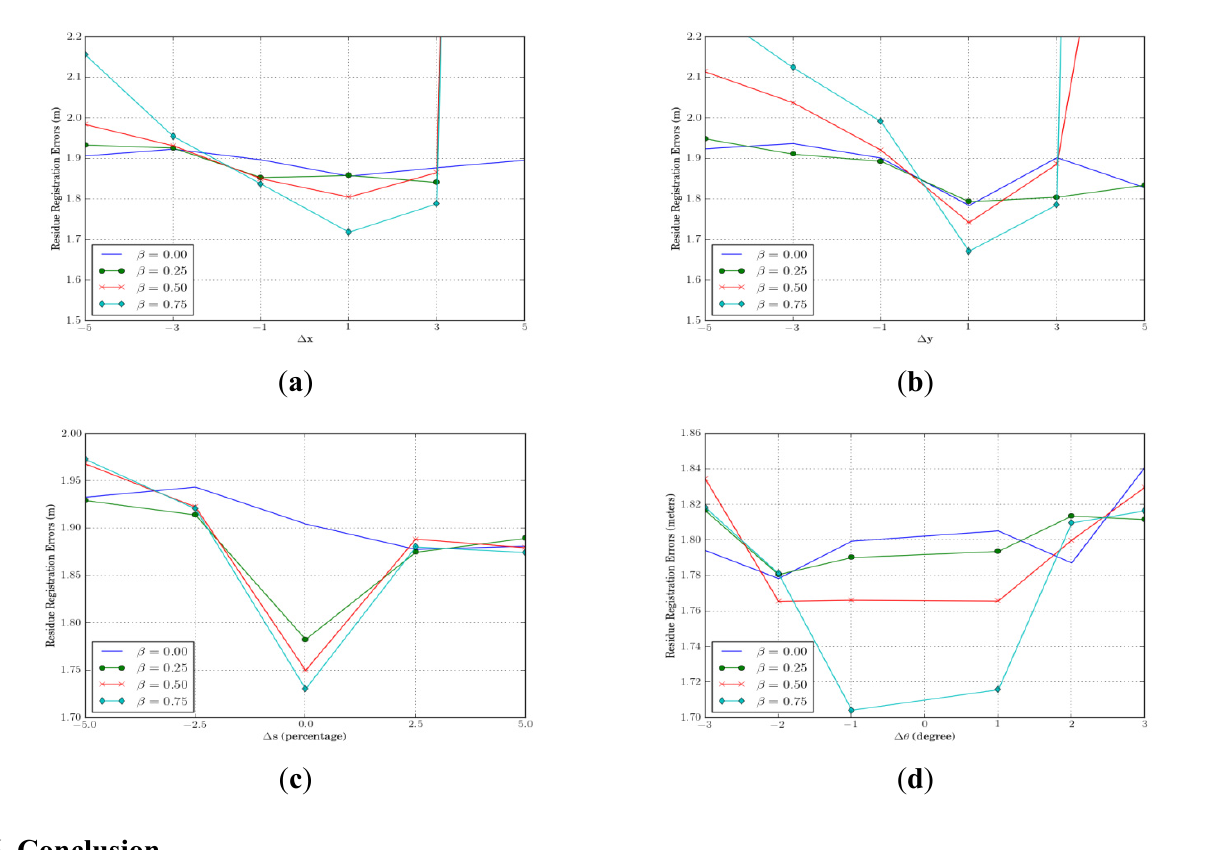
Figure 15. The effect of the initial registration errors on the residual registration error of our proposed algorithm in Example